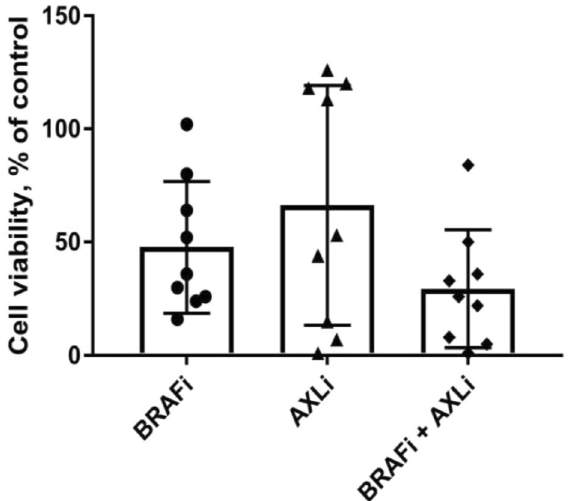
Figure 2. Ex vivo response to AXLi treatment in disaggregated cells from melanoma lymph node metastases. Cell viability of lymph node metastases cultured ex vivo and treated with 2 µM BRAFi, 3 µM AXLi or a combination of both drugs for five days. The treatment effect was scored by CTG assay and presented as % relative to the non-treated control set to 100% (Average ± SEM, n =